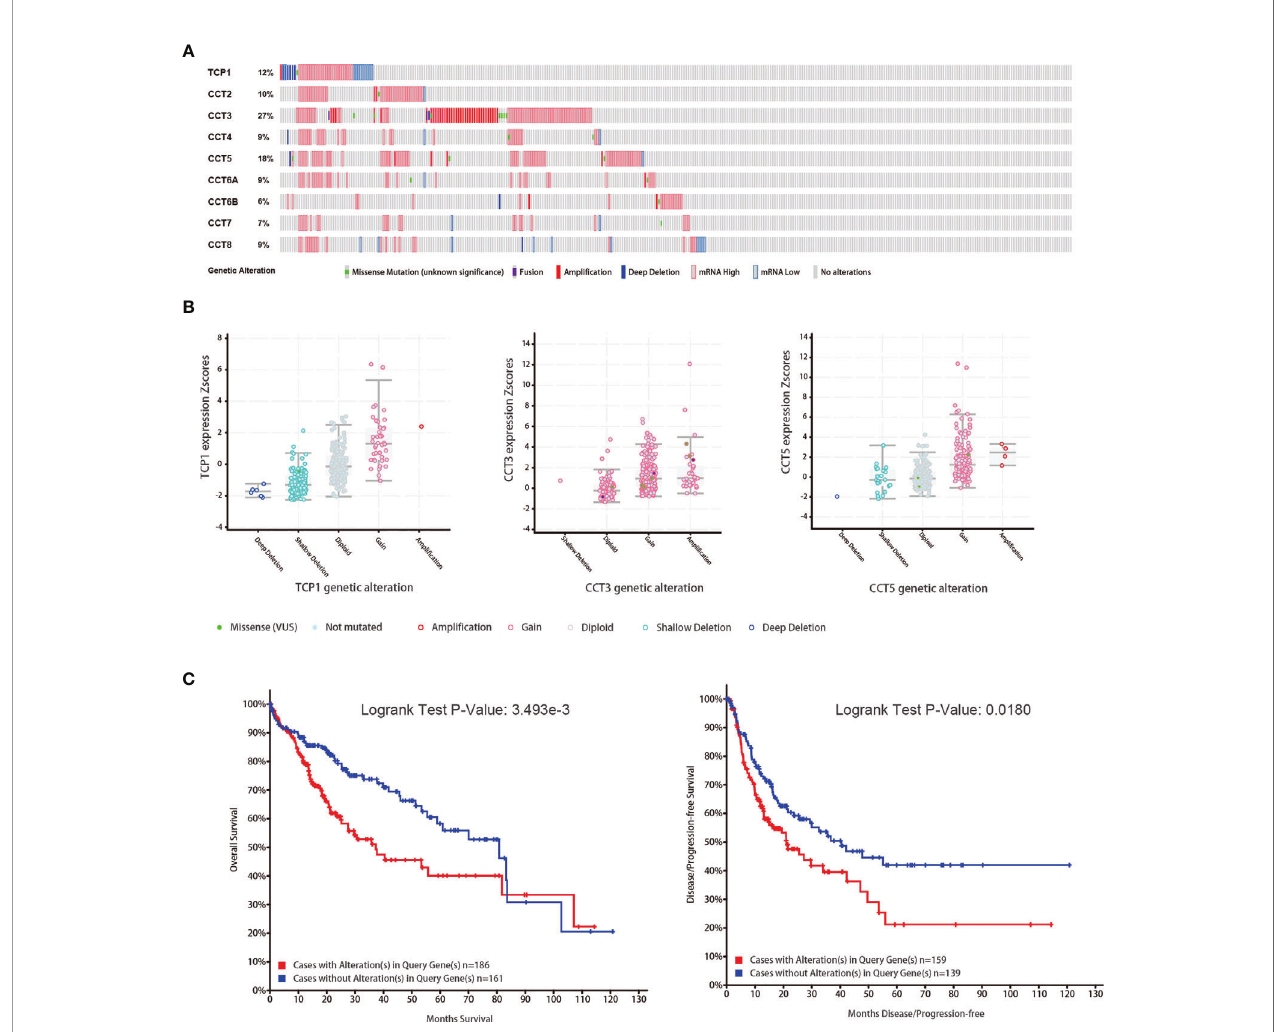
FIGURE 5 | TRiC gene mutations and altered mRNA copy numbers are association with overall survival (OS) and disease-free survival (DFS) (from cBioPortal). (A) Summary of CCT gene mutation rates. (B) CCT gene mutation types. (C) Associations of CCT mutations with OS and